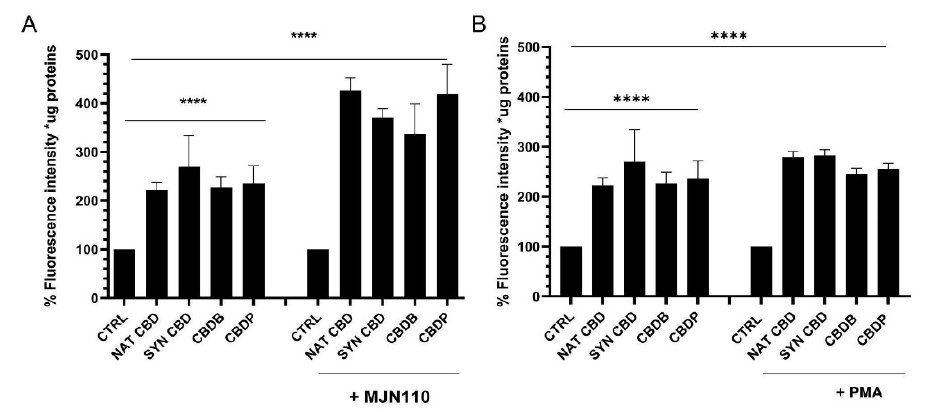
Figure 8. ( A ) Intensity quantification by a fluorescence microplate reader for DCFH-DA staining in MCF-7 cells after 24 h treatment with CBD (10 µM), and MJN110 (1 µM) + CBD homologs. Values are the mean ± SD. **** p < 0.0001 compared with controls. ( B ) Intensity quantification by a fluorescence microplate reader for DCFH-DA staining in MCF-7 cells, including control samples (DMSO) and cells treated for 24 h with CBD (10 µM), and PMA (100 nM) + CBD homologs. Values are the mean ± SD. **** p < 0.0001 compared with controls.